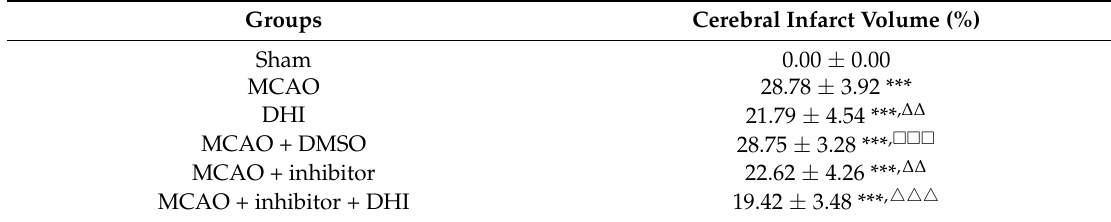
Table 5. TTC staining of the brain for the Gsk-3 β validation experiment.